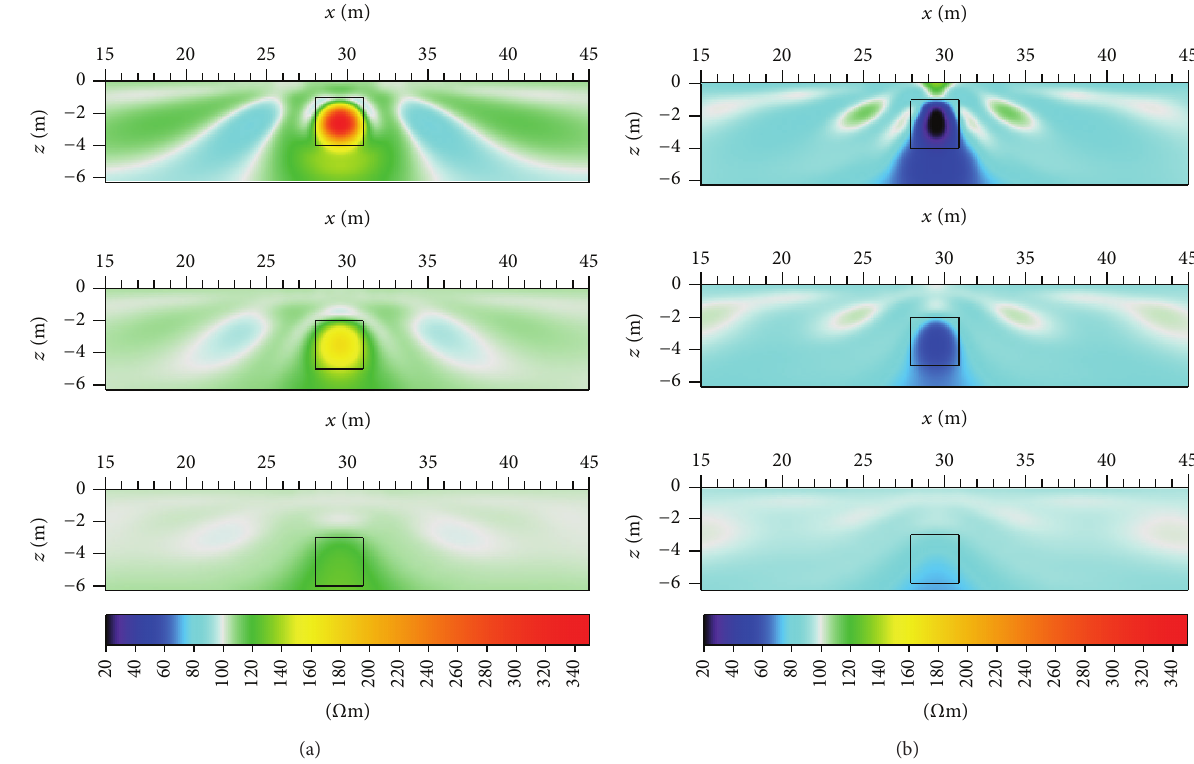
Figure6:ResultsoffilteredJacobiandampedLSQRimagingobtainedbyvaryingthedepthofananomaloussquarebody.(a)Aresistivesquare body (1000 Ω m) in a homogeneous medium (100 Ω m) and (b) a conductive square body (10 Ω m) in a homogenous medium (100 Ω